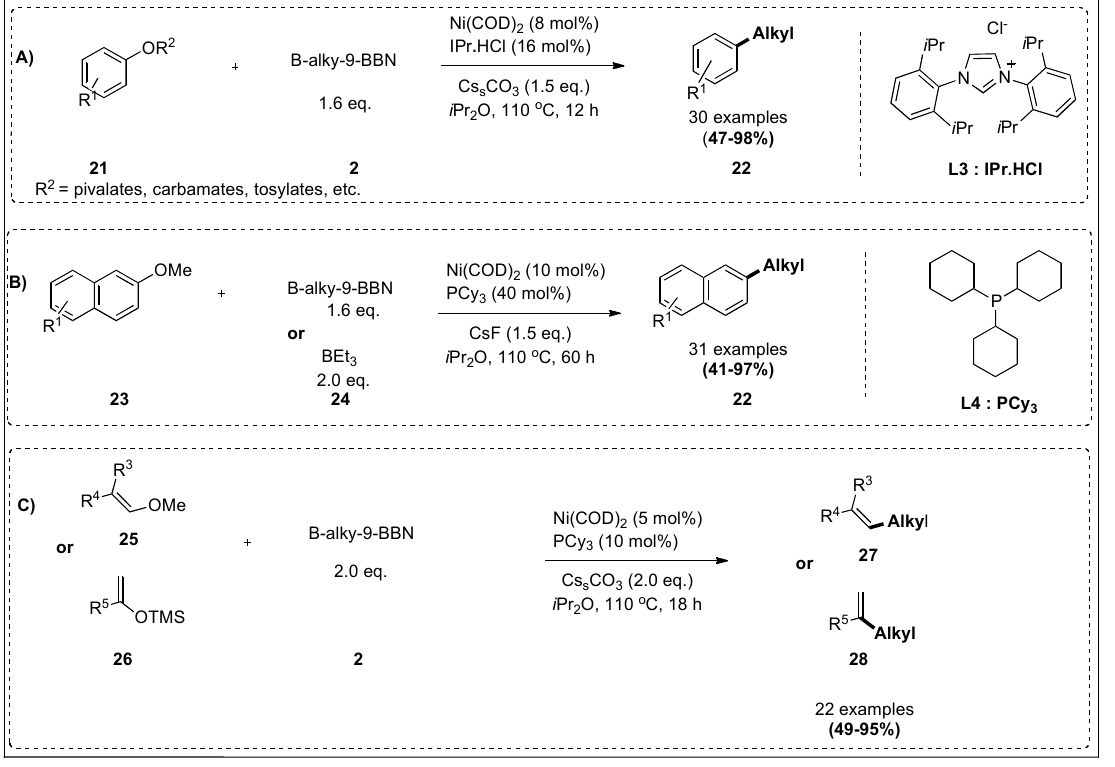
Scheme 5. Ni-catalyzed alkylation of C Ar − O electrophiles (including aromatic methyl ethers) ( A , B ) and methyl enol ethers ( C